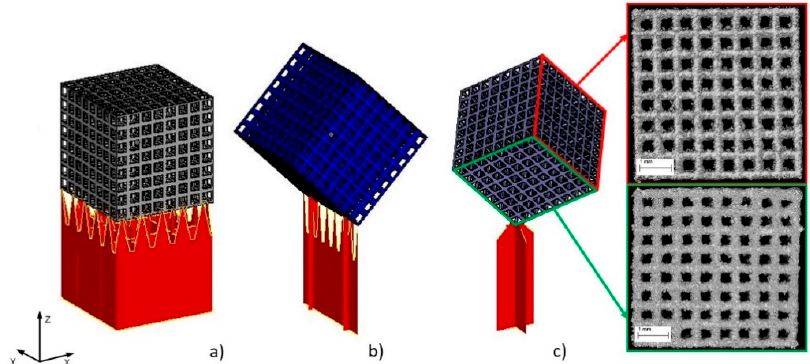
Figure 3. Specimens build orientation: ( a ) type A1—specimen surface parallel to build platform; ( b ) type A2—specimen built on edge; ( c ) type A3—specimen built on corner.